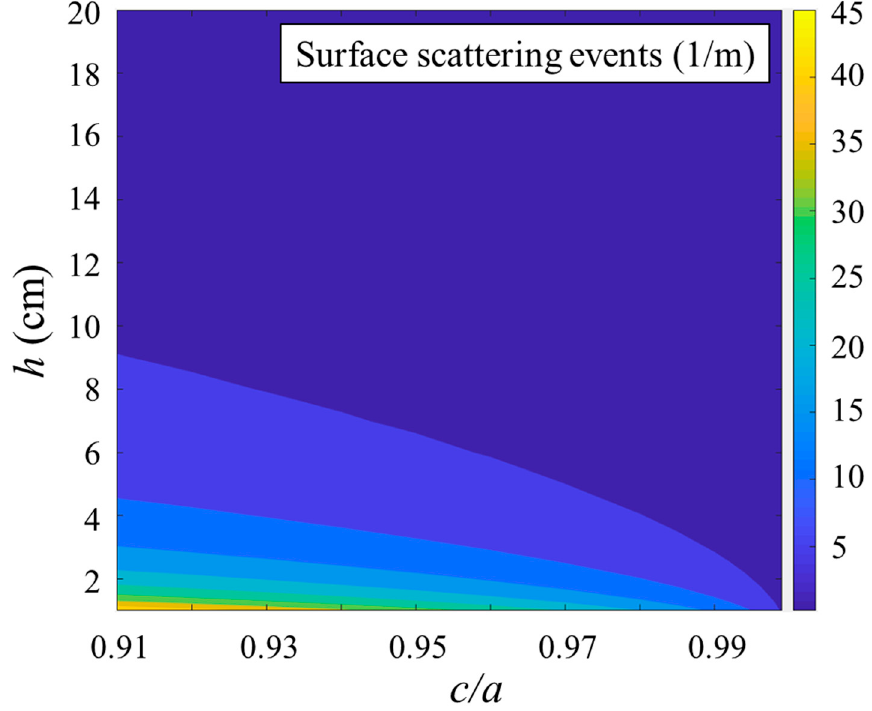
Figure 4. Number of surface scattering events per meter, within an EASSS panel plotted as a function of h and c/a